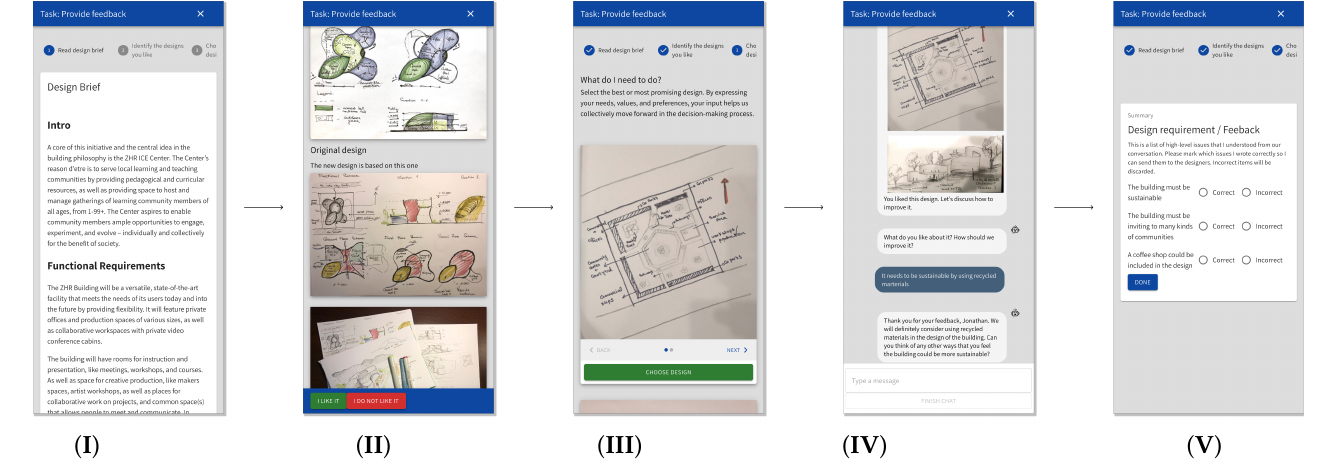
Figure 3. Selection and review tasks user flow screens (from left to right): ( I ) The design brief is presented to provide the context of the project. ( II ) New and baseline designs are presented, and the most appealing designs are marked. ( III ) The marked designs are presented, and only one is selected.